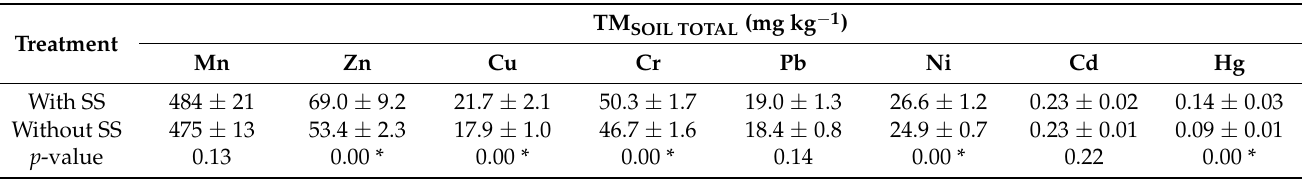
Table 4. Mean ± standard deviation of the total concentration of Mn, Zn, Cu, Cr, Pb, Ni, Cd and Hg in soil, depending on whether they have received SS or not, together with their p -value.